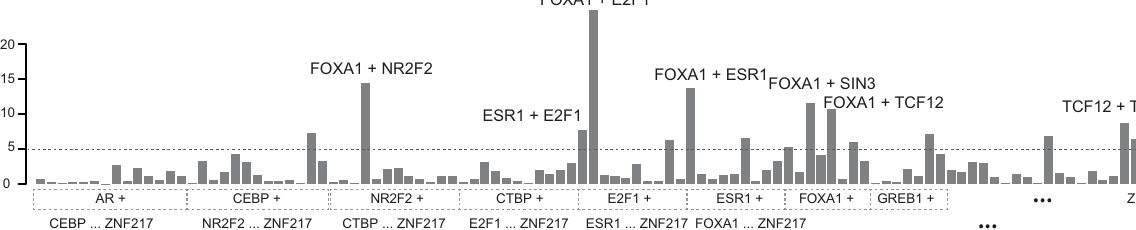
Fig. 2 Association of co-occupancy of two TFs with breast cancer risk in BCAC data. a In the upper-right triangle, the numbers of genetic variants (multiplied by 1000) that are occupied by speci fi c TFs or co-occupied by two TFs were showed for each TF pair. In the lower-left triangle, barplots showing the association strengths (regression coef fi cients) for the genetic variants occupied by two TFs (only fi rst TF and only second TF, respectively) as indicated by dark blue to gray-blue colors. Two TFs with signi fi cant interactions at P < 1 × 10 − 5 were highlighted in red. b Barplots show interaction between two TFs with signi fi cant interactions indicated on the top: FOXA1 + E2F1, FOXA1 + NR2F2, FOXA1 + ESR1, FOXA1 + SIN3, and FOXA1 + TCF12, at P < 1 × 10 − 5